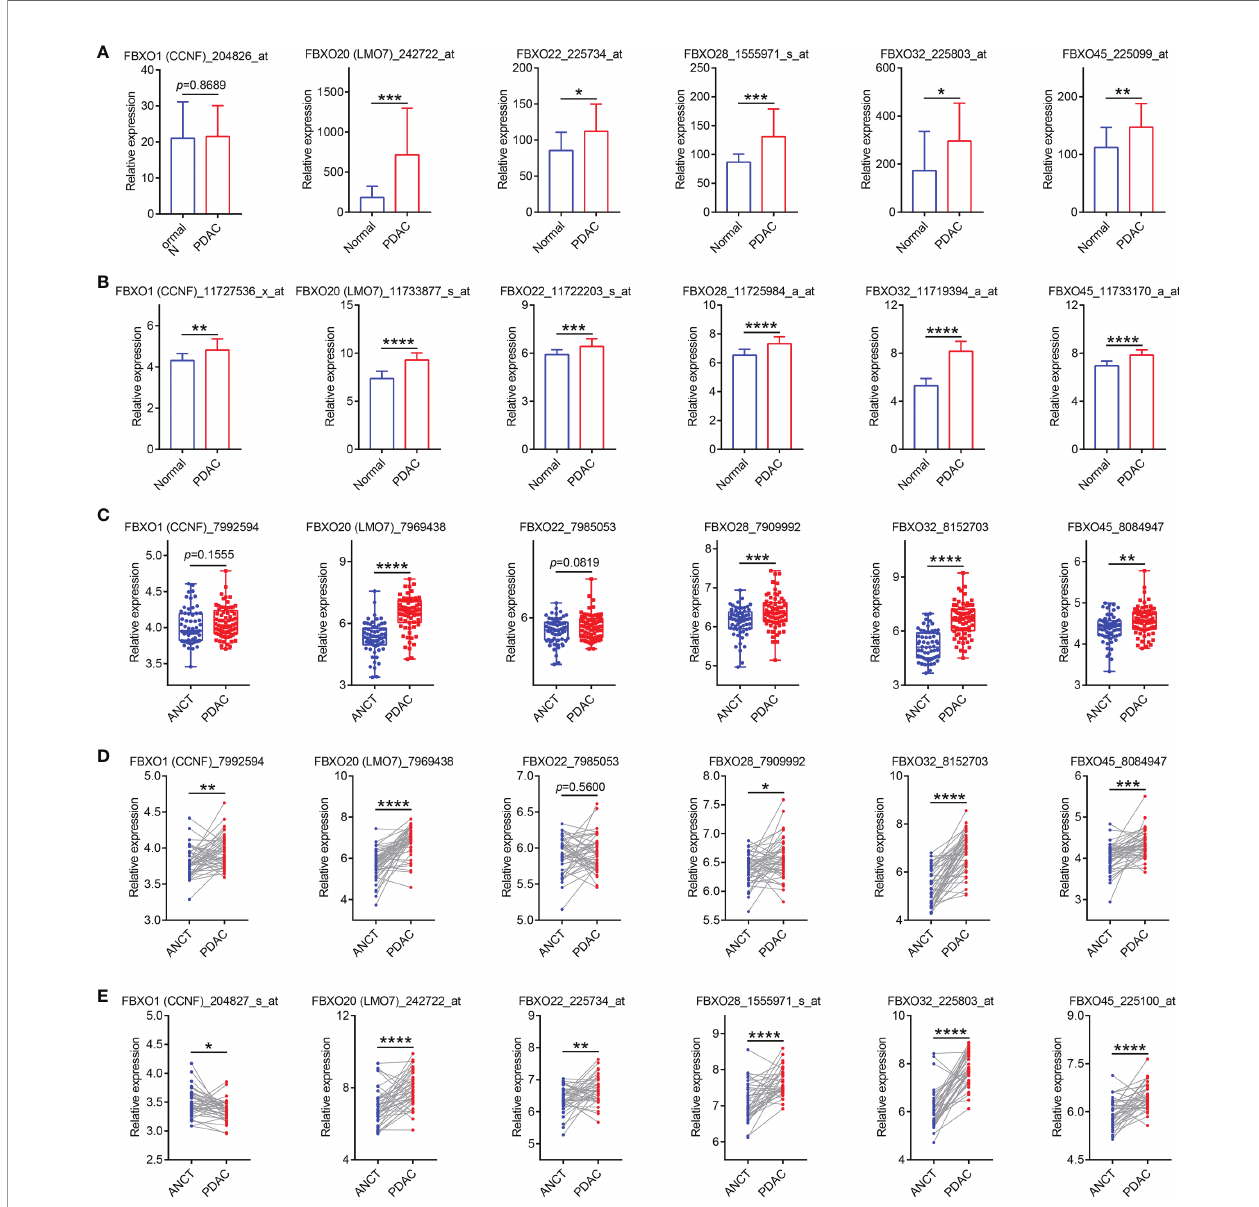
FIGURE 2 | Five GEO datasets were collected to validate the abnormality in the expression patterns of six-FBXOs in pancreatic ductal adenocarcinoma (PDAC). (A) The mRNA levels of six-FBXOs via the comparison between PDAC ( n = 36) and normal pancreatic tissues ( n = 16) in GSE16515 dataset. (B) The expression levels of six-FBXOs in PDAC tissues ( n = 118) compared with normal tissues ( n = 13) in GSE62165 dataset. (C) The expression levels of six-FBXOs in PDAC tissues ( n = 69) versus adjacent non-cancerous tissues (ANCT) ( n = 61) in GSE62452 dataset. (D) The transcriptional levels of six-FBXOs in PDAC tissues compared with ANCT ( N = 45 pairs) in GSE28735 dataset. (E) The expression levels of six-FBXOs in PDAC tissues compared with ANCT ( N = 39 pairs) in GSE15471 dataset. The code behind the gene is the probe name in different GEO datasets. * P < 0.05, ** P < 0.01, *** P < 0.001, **** P <